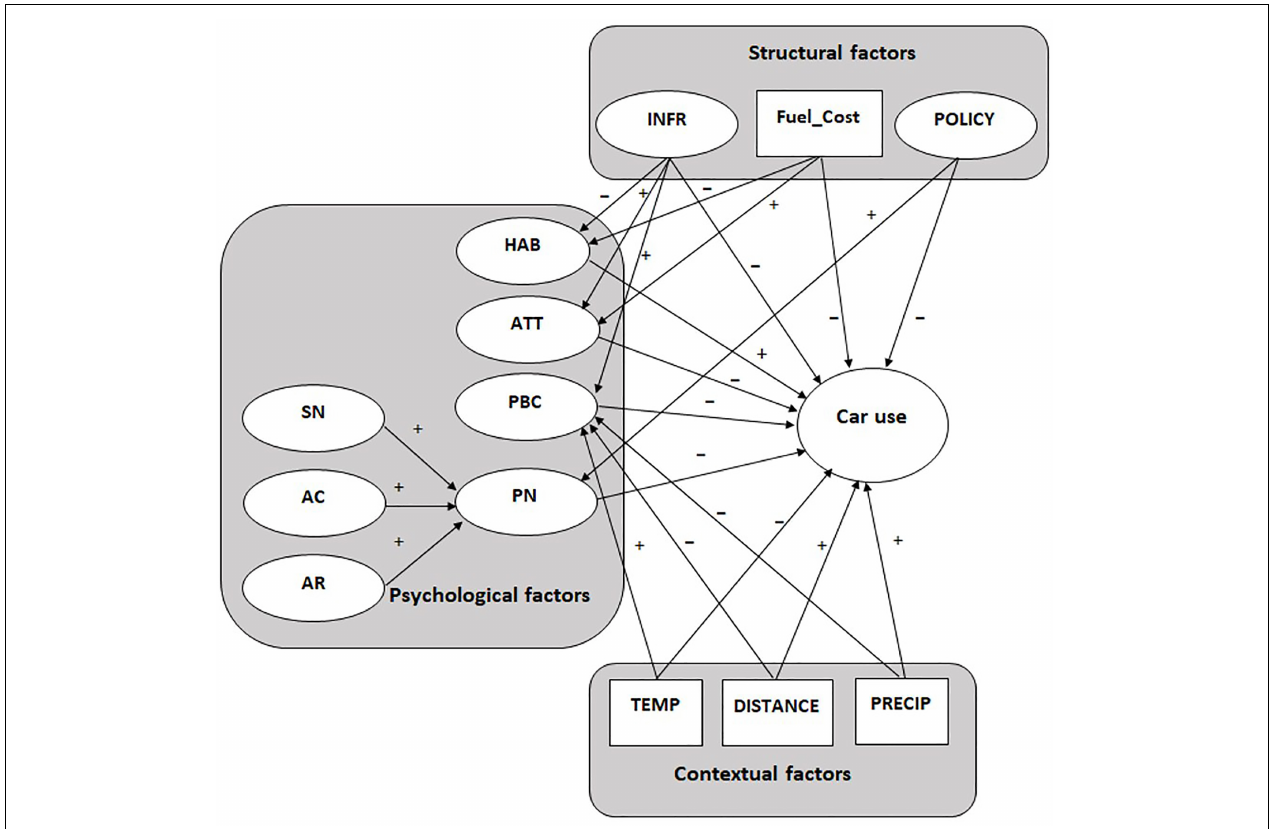
FIGURE 1 | The specified integrative